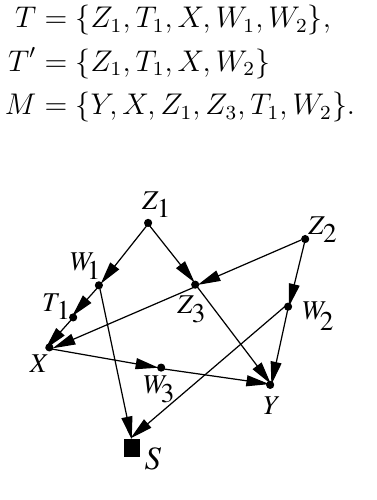
Figure 3: Selection bias can be removed if measurements on the set M = { Y, X, Z , Z , T , W } are available in the study and the joint probability of T = 1 3 1 2 { X, T , Z , W } is estimable from external 1 1 2